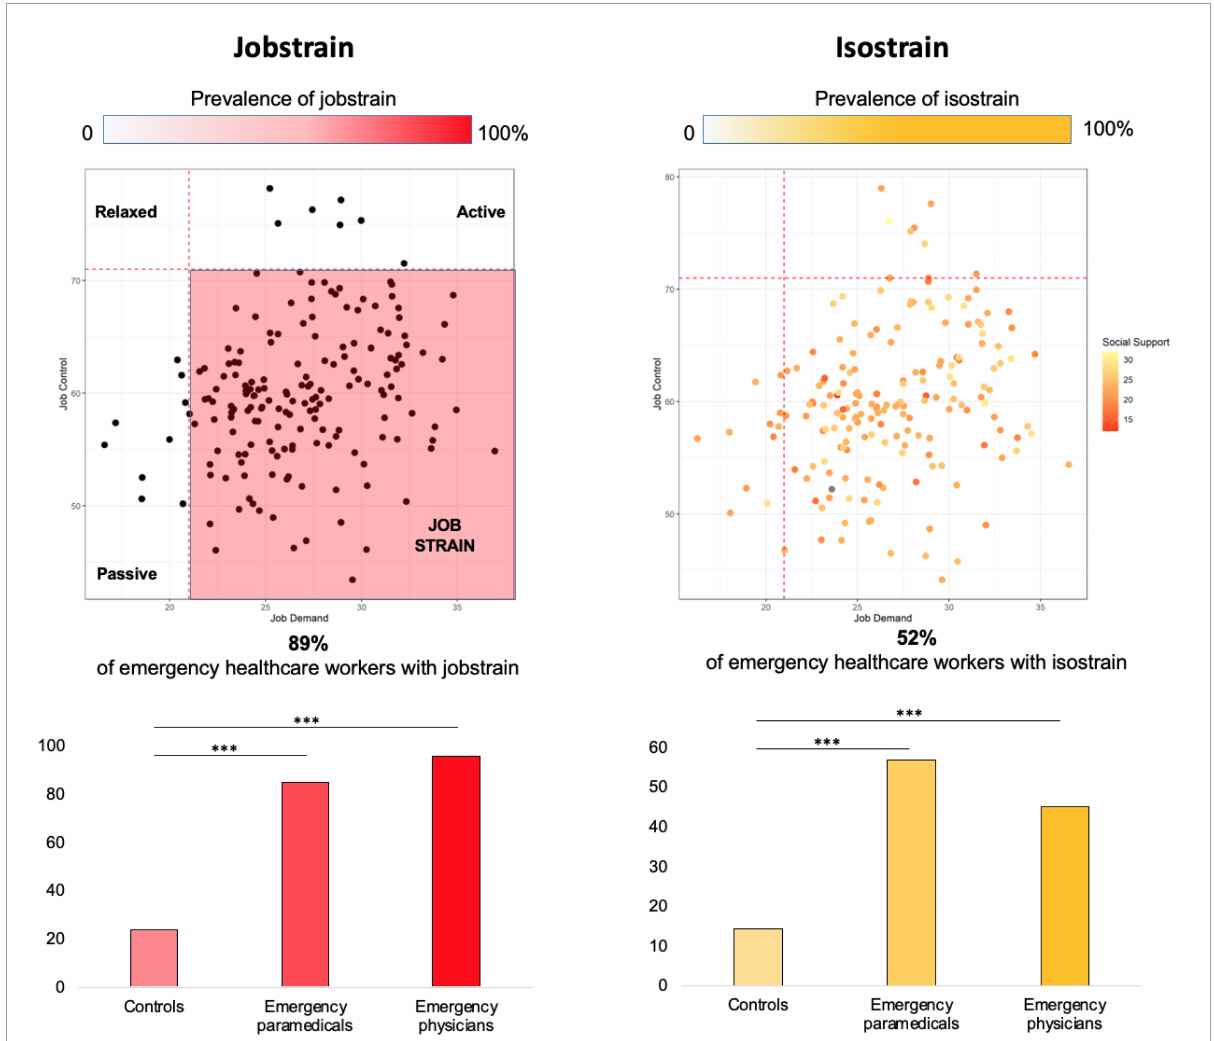
FIGURE5 Prevalence of job strain and isostrain among our population of emergency healthcare workers. ∗∗∗ p < 0.001. Results are significant if p < 0.05. Patients are considered in job strain if job demand is > 21 and job control is < 70. Patients are considered isostrain if they have job strain and social support <